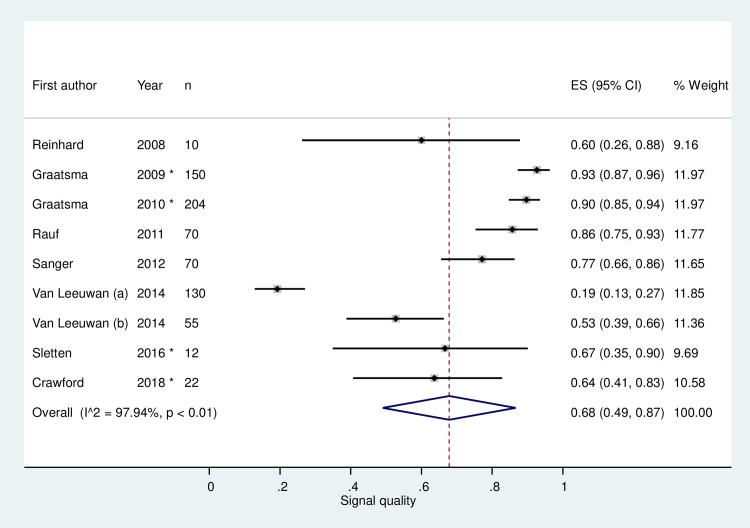
Estimated average signal quality of fetal electrocardiography recordings from eight studies which used the Monica AN24 device.Black markers represent the signal quality with 95% confidence intervals (CI) (whiskers). The size of each grey square represents the relative weight in the meta-analysis. The diamond represents the signal quality summary value. Asterisk (*) represents studies which had the median and interquartile range/range data converted to the mean and standard deviation.